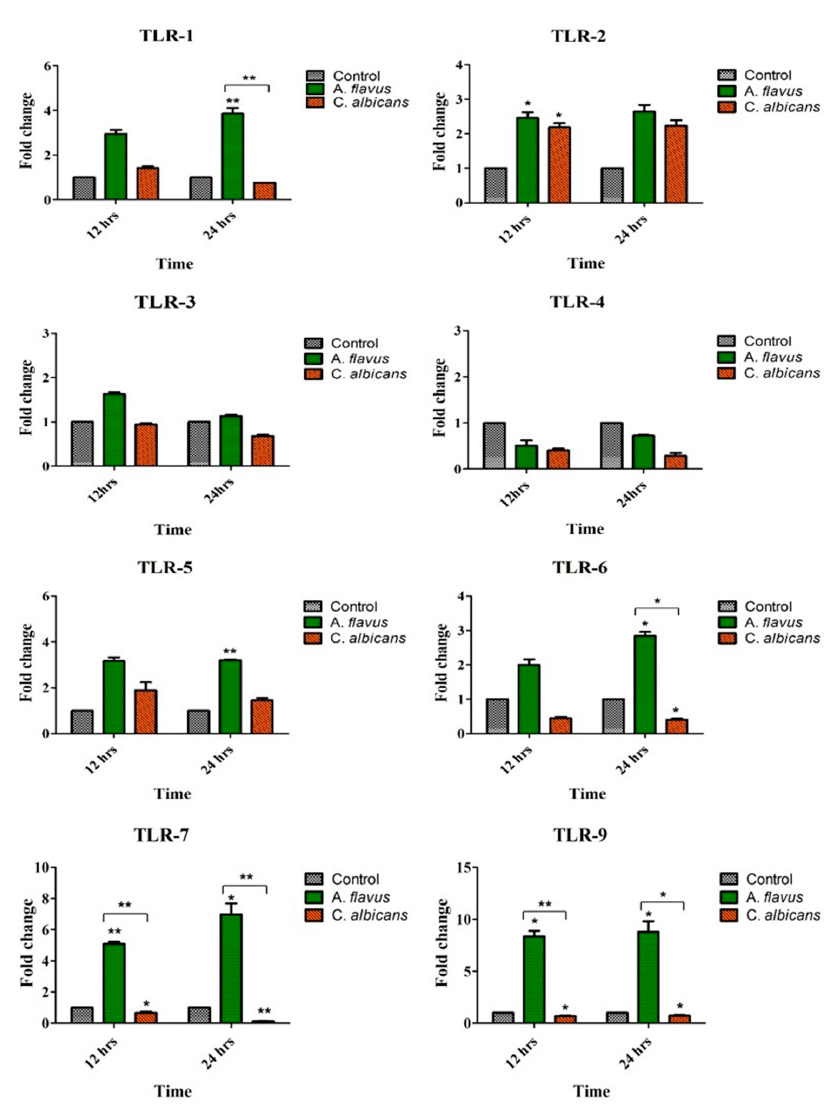
Figure 1. CHME-3 cells were challenged with A. flavus and C. albicans at indicated time points. Postinfection human microglial total RNA was subjected to RT-PCR and qRT-PCR using SYBR green assay for Toll-Like Receptors (TLRs) (1-7 and -9) and β -actin gene was used as internal control and uninfected CHME-3 cells were taken as control. The data were shown as the mean ± Standard error (SE) from three sets of independent experiments and * p < 0.05, ** p < 0.005.